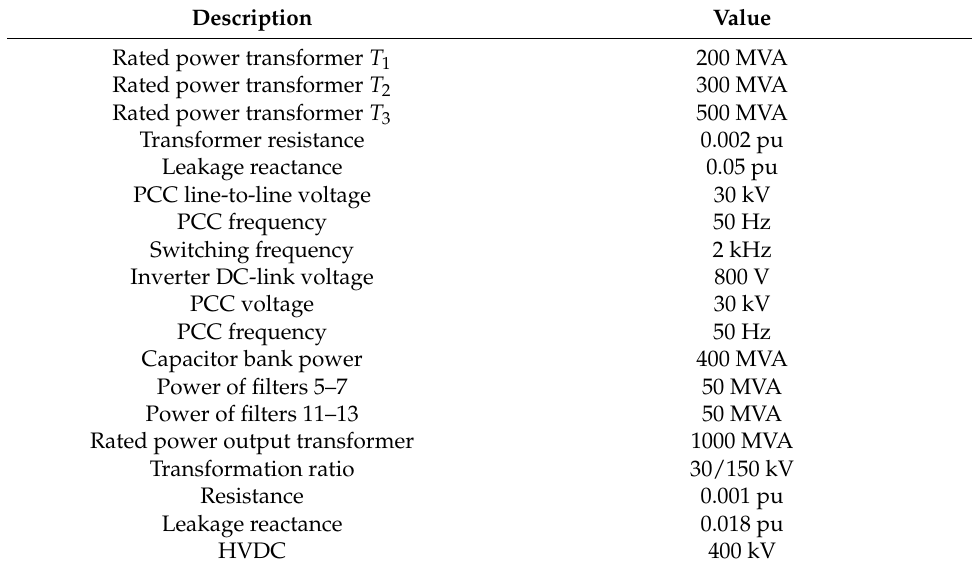
Table 1. Simulation parameters.